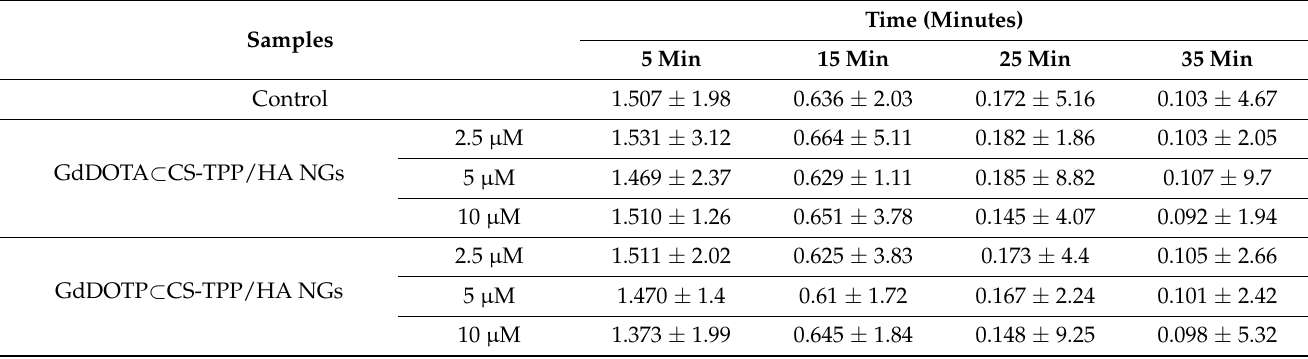
Table 2. The thrombogenic potential exposed at various doses (2.5, 5 and 10 µ M) of GdDOTA ⊂ CS- TPP/HA and GdDOTP ⊂ CS-TPP/HA